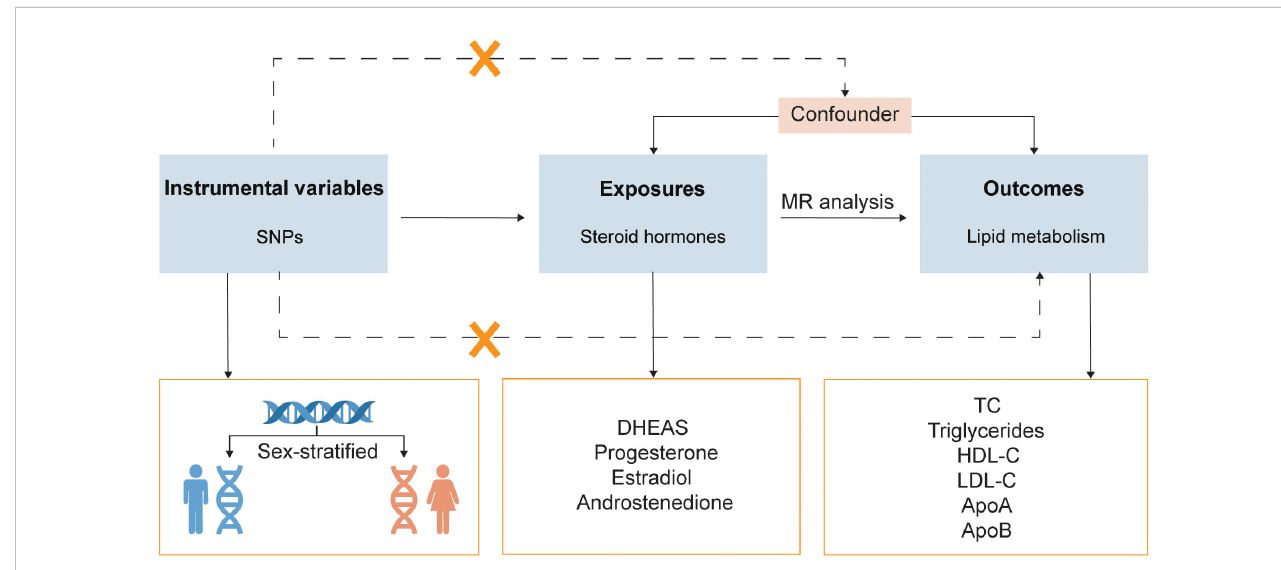
FIGURE 1 Study design overview. SNPs, single-nucleotide polymorphisms; MR, Mendelian randomization; DHEAS, dehydroepiandrosterone sulfate; HDL-C, high- density lipoprotein cholesterol; LDL-C, low-density lipoprotein cholesterol; TC, total cholesterol; ApoA, apolipoprotein A; ApoB, apolipoprotein